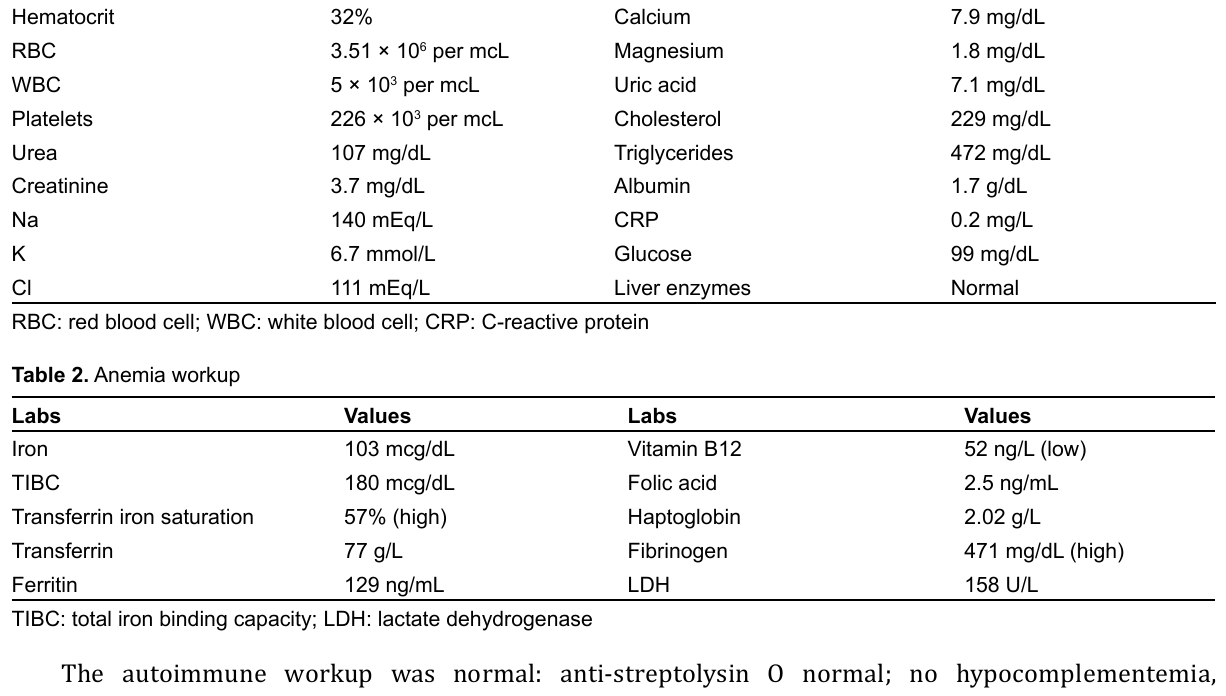
C3: 92 mg/dL normal; C4: 28 mg/dL normal, anti-nuclear antibody negative, anti-neutrophil cytoplasmic antibody negative; perinuclear anti-neutrophil cytoplasmic antibody negative;